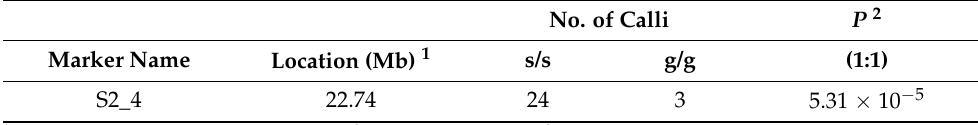
Table 2. Segregation distortion observed in calli derived from another